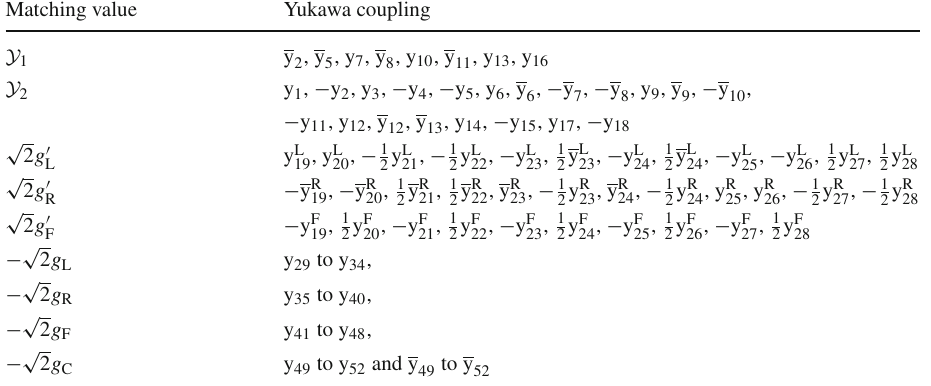
matching conditions. The y i couplings refer to the ( L → R ) part of L